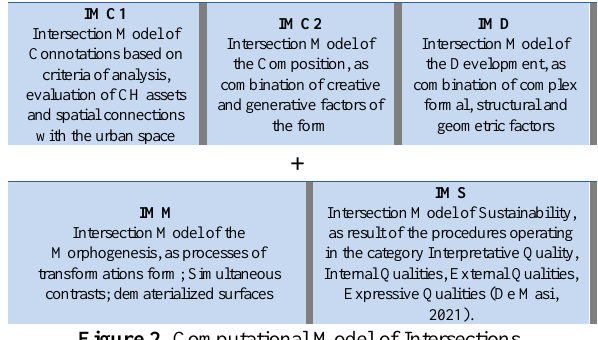
Figure 2. Computational Model of Intersections